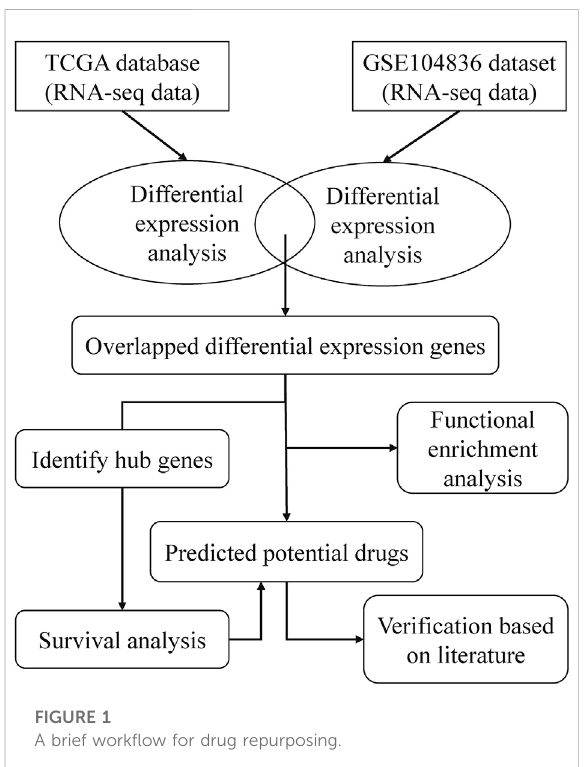
FIGURE 1 A brief work fl ow for drug repurposing.